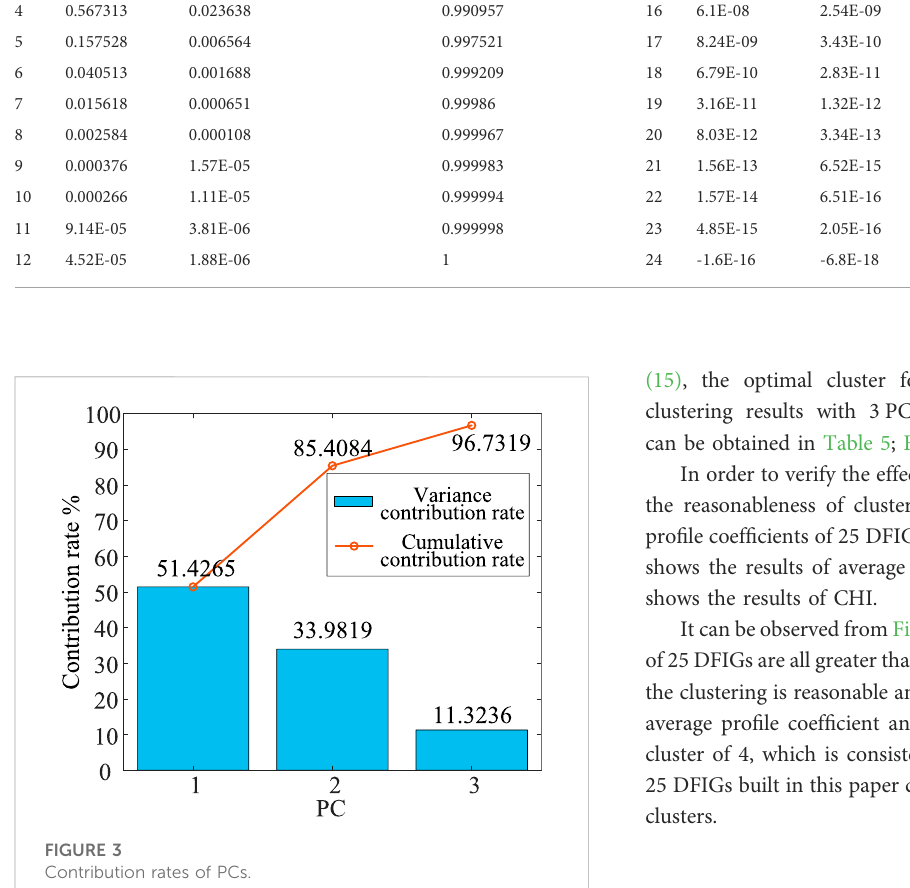
FIGURE 3 Contribution rates of